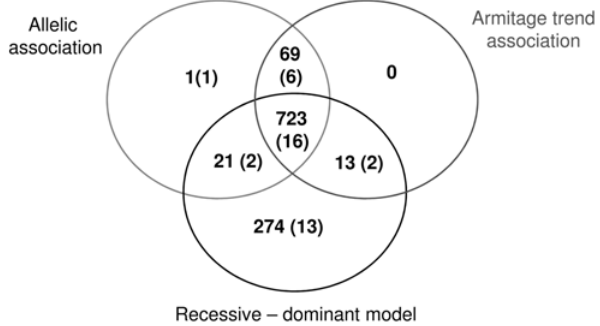
Figure 2. Selection and Verification of SNPs And Haplotypes from the GWAS Analysis. GWAS SNPs and haplotypes were ranked by P-value and the top 1101 (of 14,065 total associated) SNPs and 35 (of 3,549 non-overlapping total associated) haplotypes were carried through to the follow-up stage. Numbers in parenthesis indicate the number of variants selected from the GWAS by each method of selection that were subsequently replicated in the family-based study.